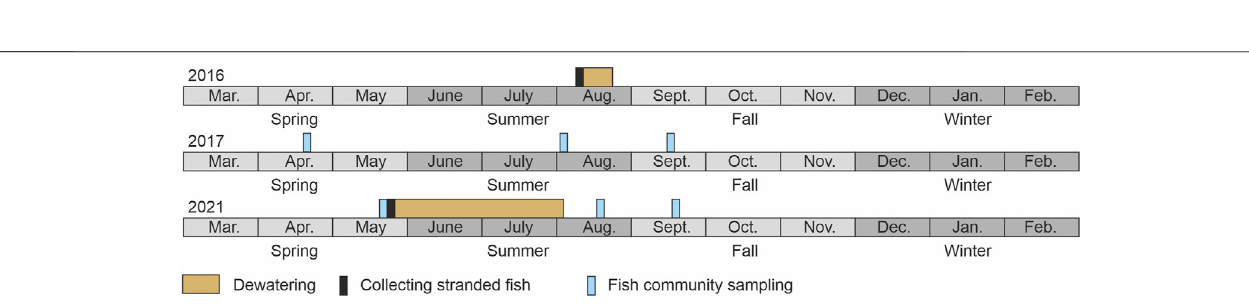
Frontiers in Environmental Science |